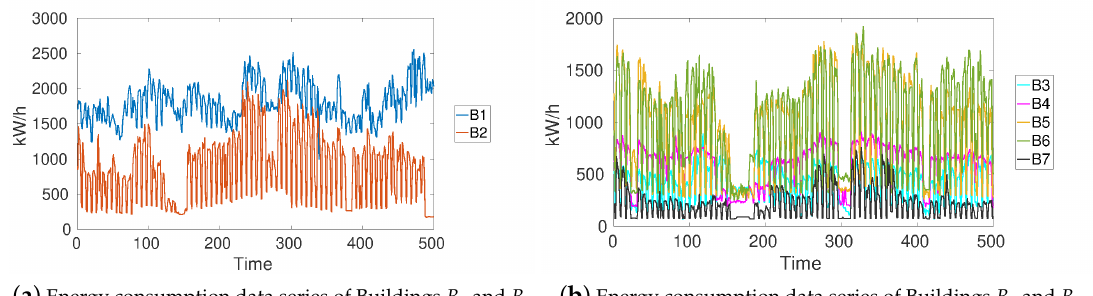
Figure 5. Energy consumption data series of cluster of buildings E 1 and E 2 during 500